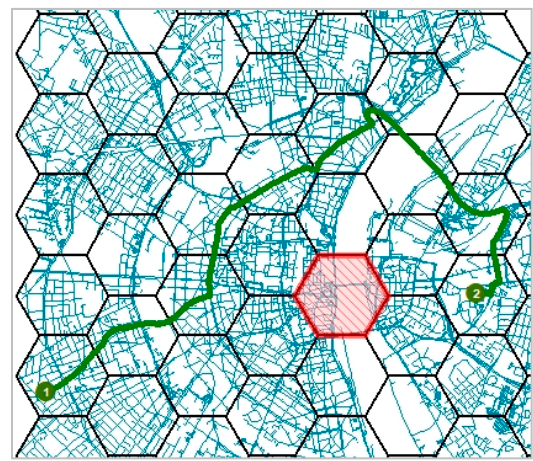
Figure 2. Route blocked with higher impact: Response time 11.8 min (Legend: green = route; grey = road network, red = blocked tile).